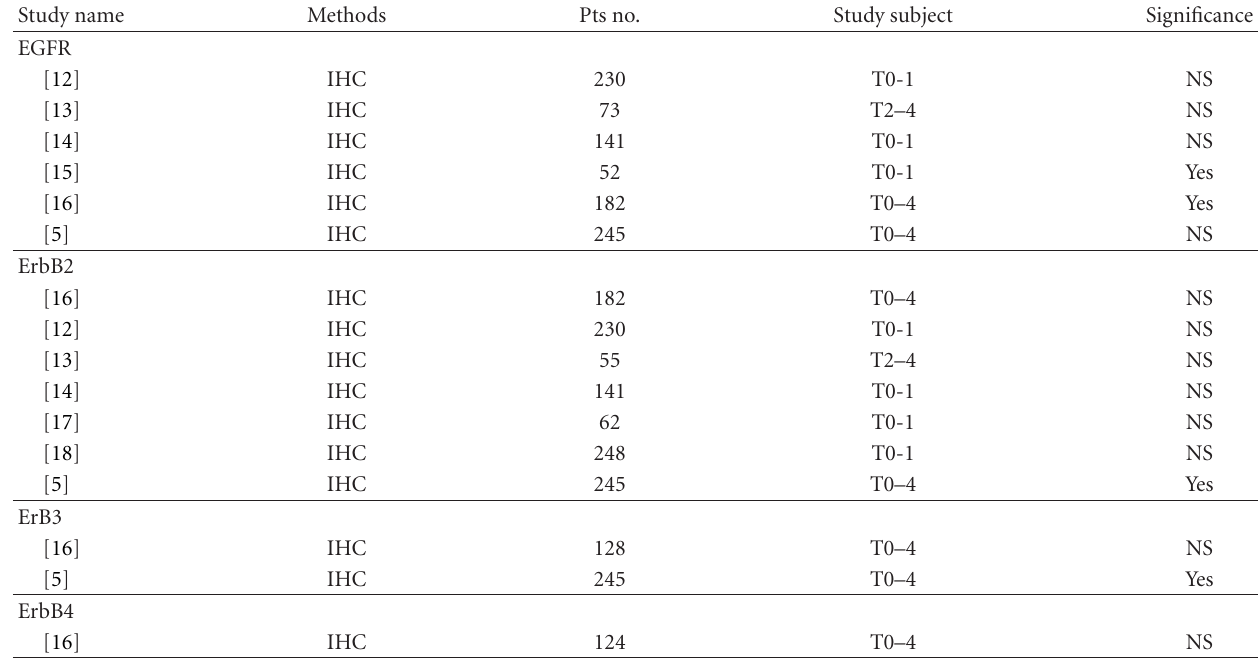
Table 1: Significance of ErbB receptor family as a marker for tumor